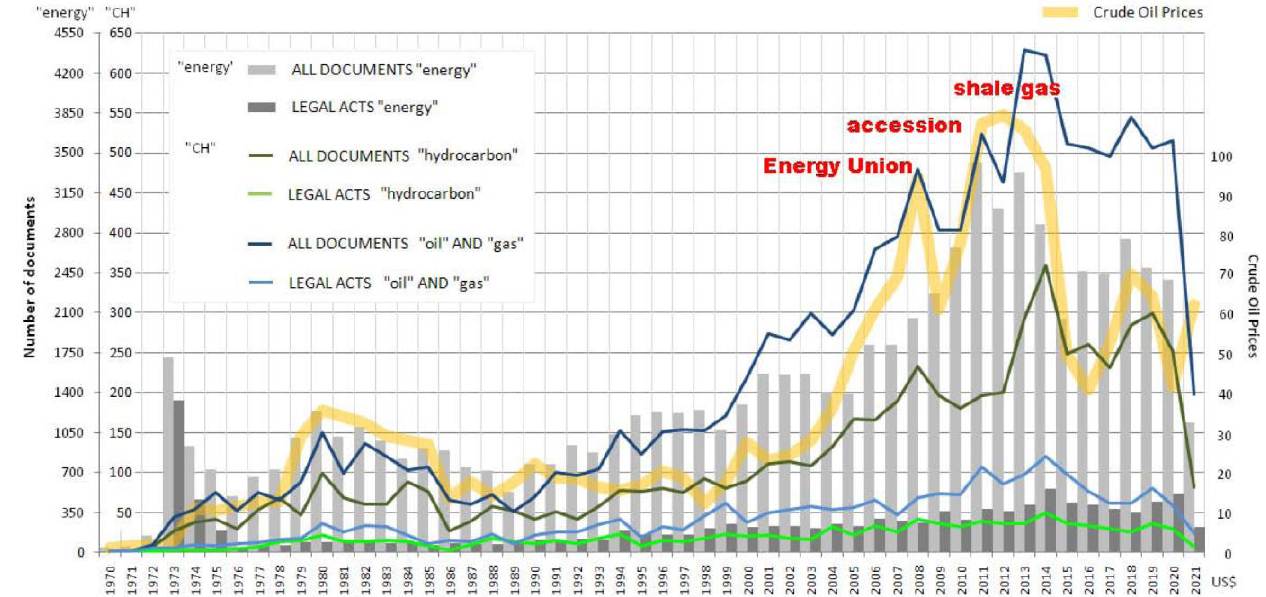
Figure 2. The trend of energy and hydrocarbons related documents and legal texts in the EU versus oil price and other events during the last half century.